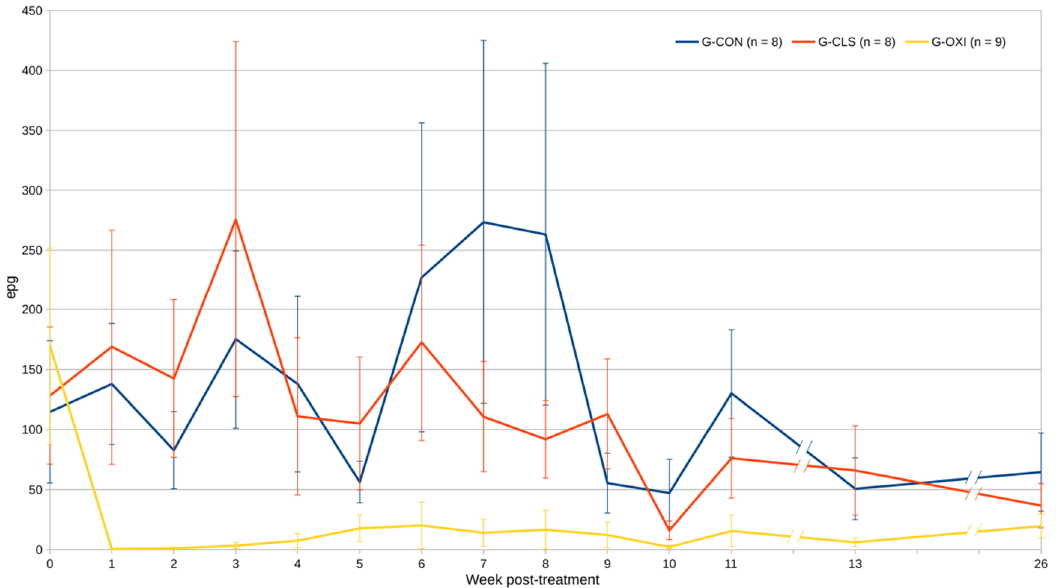
Figure 1. Arithmetic means and standard errors of paramphistomid egg shedding (eggs per gram, epg) in the three groups of sheep (G-CON, untreated controls; G-CLS, treated with closantel; G-OXI, treated with oxyclozanide) during the study period (26 weeks after treatment).